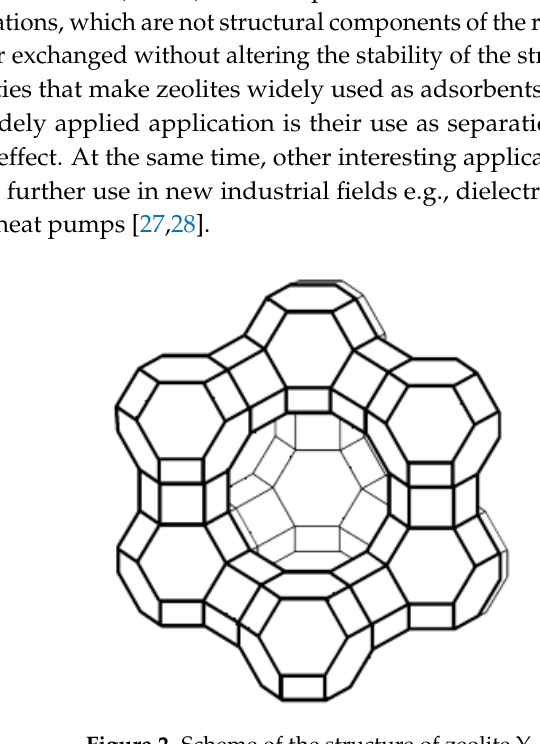
Figure 2. Scheme of the structure of zeolite Y.